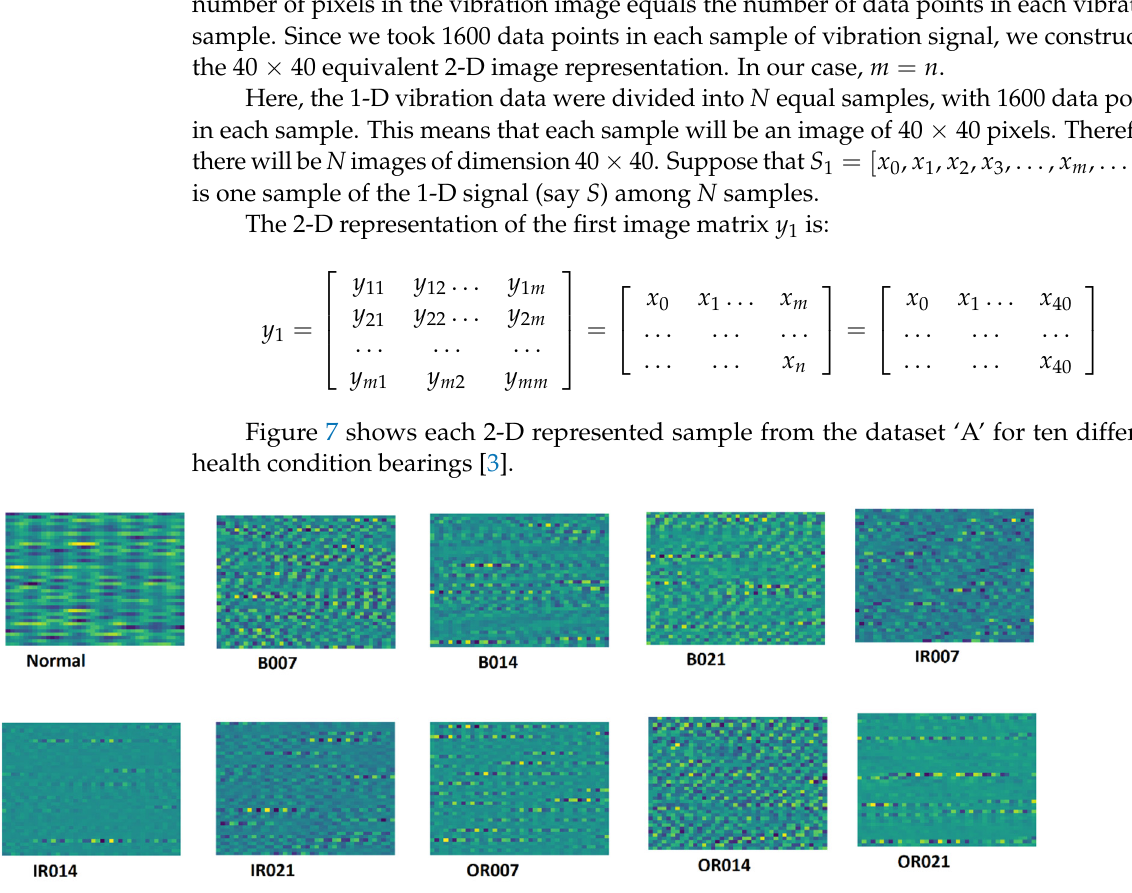
Figure 7. Bearing vibration images of ten different health conditions.